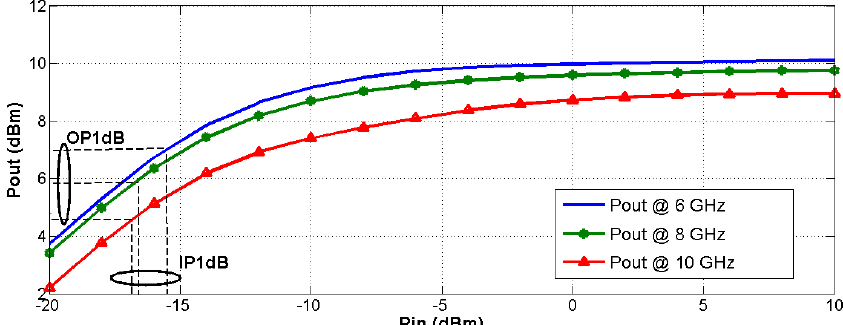
Figure 13. P OUT versus P IN at different frequencies within desired band.